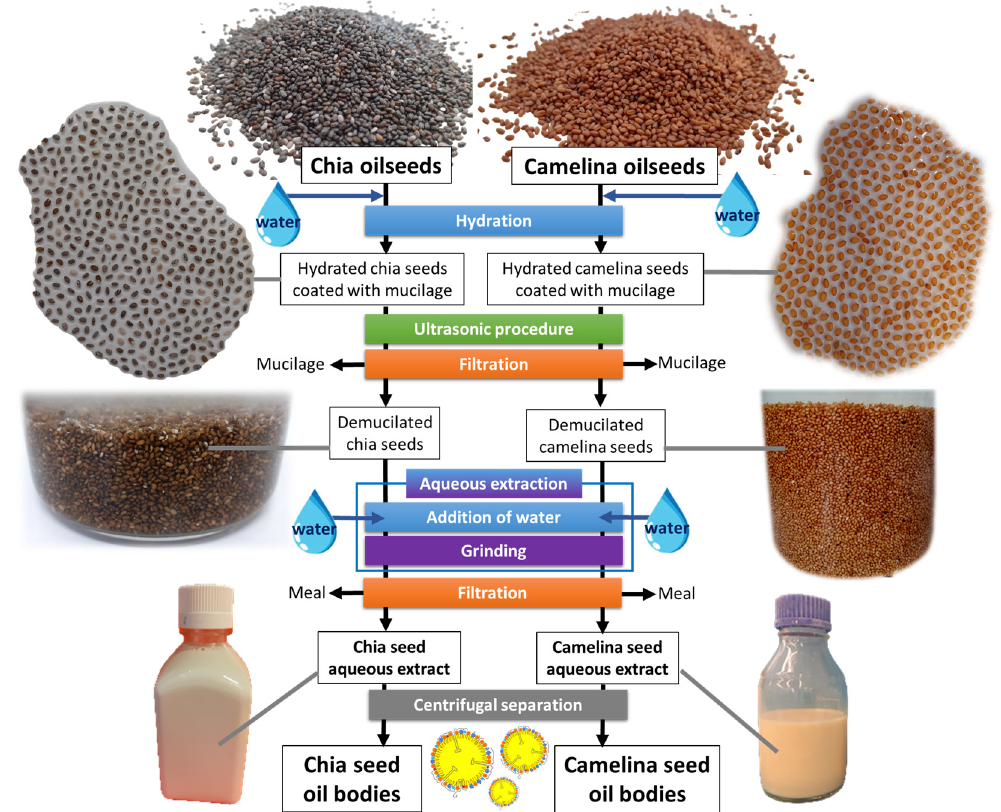
Figure 1. Schematic diagram of the integrated green refinery process used for the release of oil bodies after aqueous extraction from chia seeds or camelina seeds. Images show the chia and camelina seeds, hydrated chia and camelina seeds coated with mucilage, mucilage-free chia and camelina seeds obtained after ultrasonication and removal of the mucilage and the aqueous extracts.